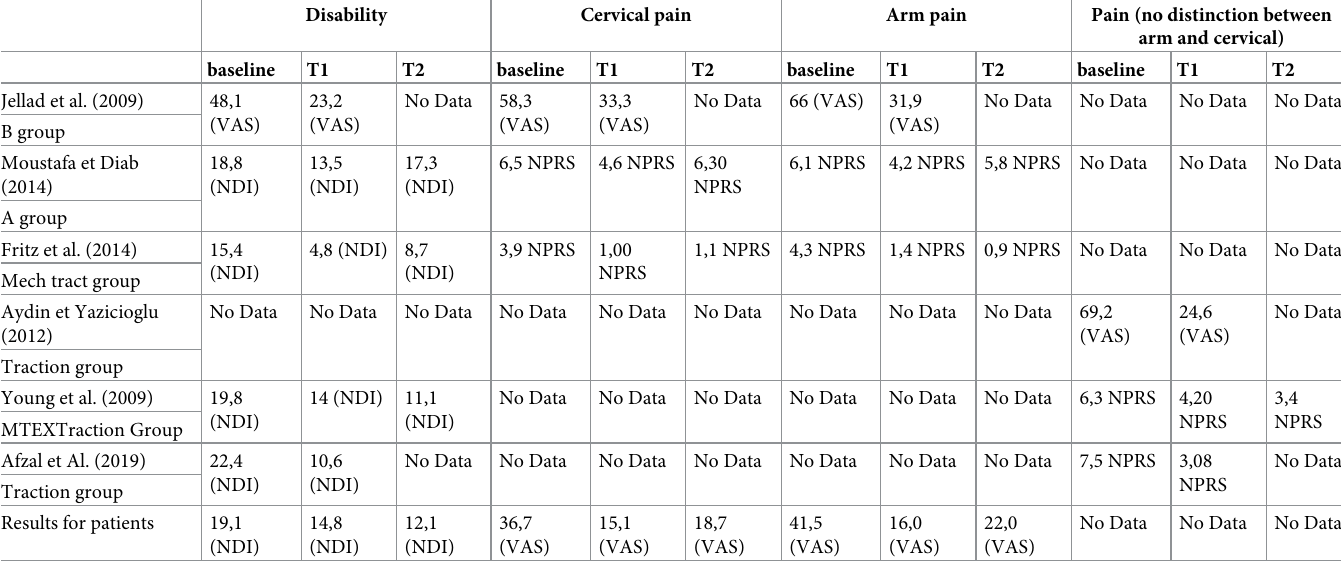
Table 2. Comparison of effects of traction in the